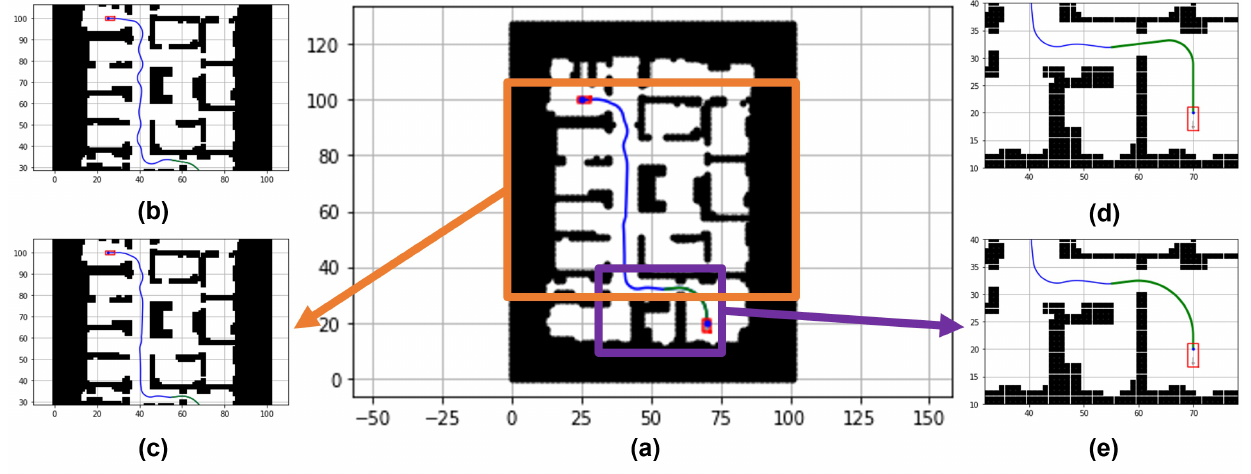
Figure 8. Improved hybrid A-star in a benchmark map map12 . ( a ) Improved hybrid A-star. ( b ) Before tunings. ( c ) After tunings. ( d ) Original RS path. ( e ) Improved RS